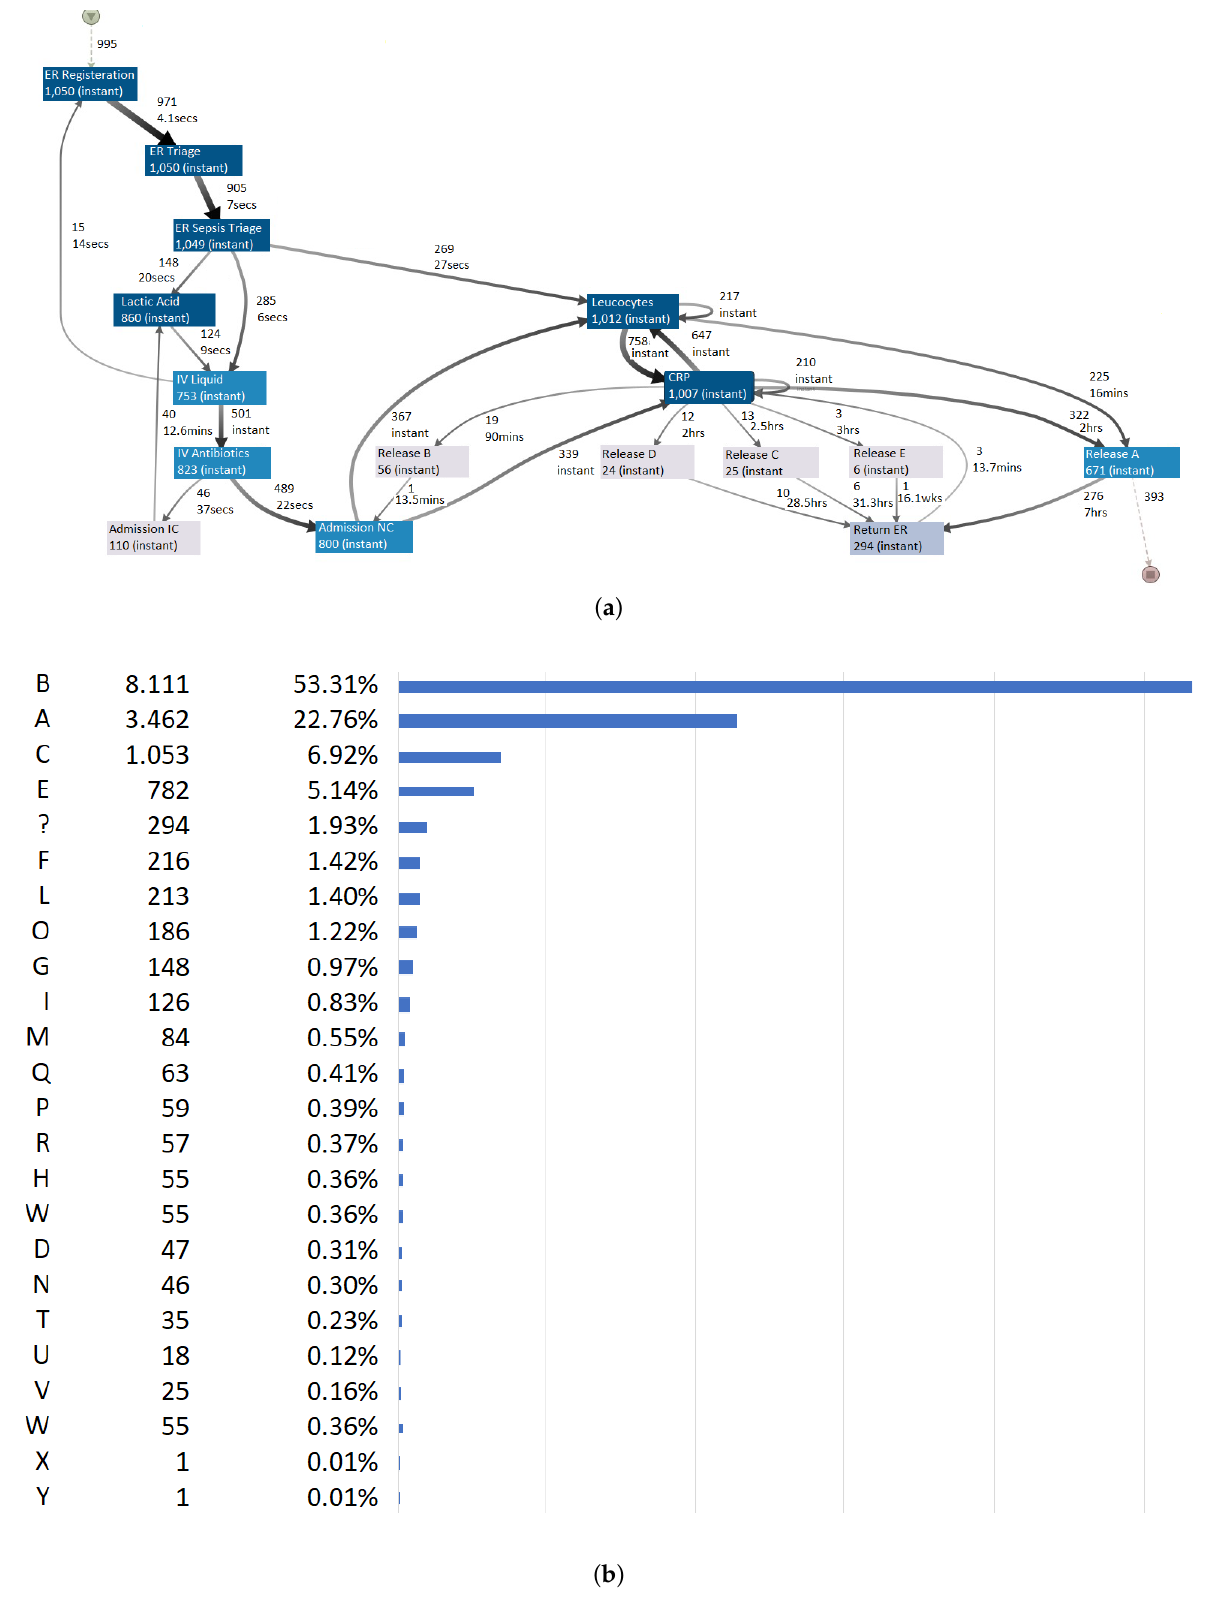
Figure 5. ( a ) Sepsis process model (using Disco tool): patients’ un-anonymized care metadata share amongst horizontally distributed caregivers; ( b ) Legend for Sepsis process